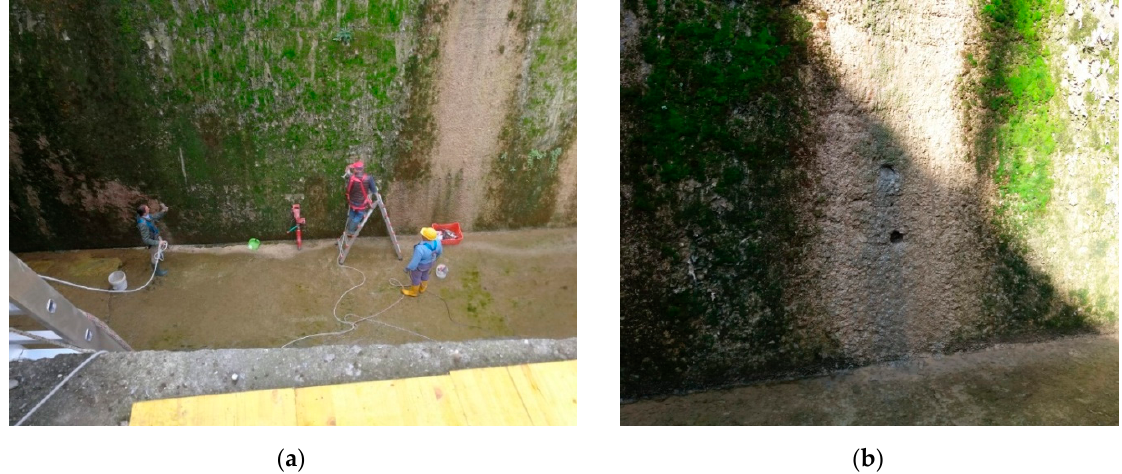
Figure 3. Investigation of the civil engineering works of a dam ( a ) and the current state of its concrete ( b ).